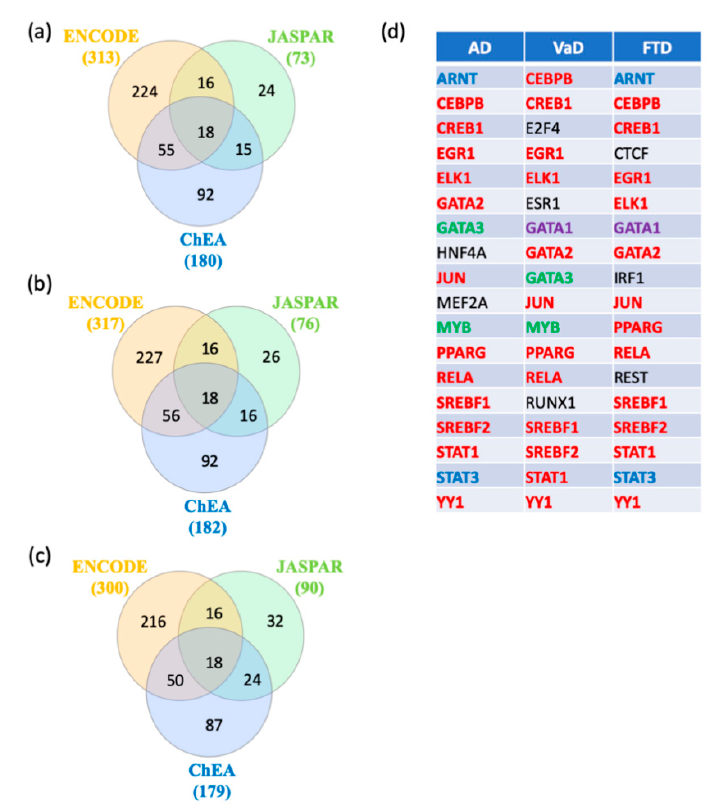
Figure 7. Transcription factors analysis. NetworkAnalyst was used for transcription factor analysis with ENCODE, JASPAR, and ChEA. Venn diagram analysis of the data revealed transcription factors shared by the three methods. ( a ) Transcription factors potentially regulating AD switch genes, ( b ) Transcription factors potentially regulating VaD switch genes, ( c ) Transcription factors potentially regulating FTD switch genes, and ( d ) List of the transcription factors potentially regulating AD, VaD and FTD switch genes. The transcription factors in red are shared between the 3 types of dementia. The transcription factors in green are shared between AD and VaD analysis. The transcription factors in blue are shared between AD and FTD analysis. The transcription factor in purple is shared between VaD and FTD analysis. The transcription factors in black are unique to a particular dementia.